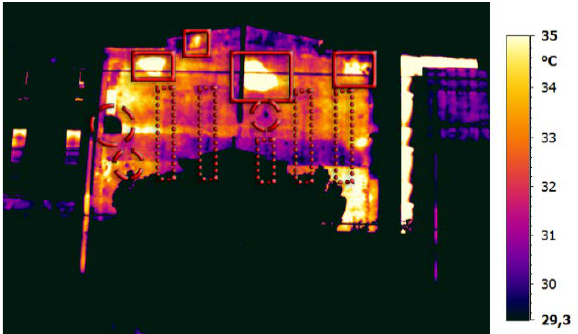
Figure 1 – The southern façade of St. Pio X Church (Case Study 1), facing Piazza Leonardo da Vinci square.